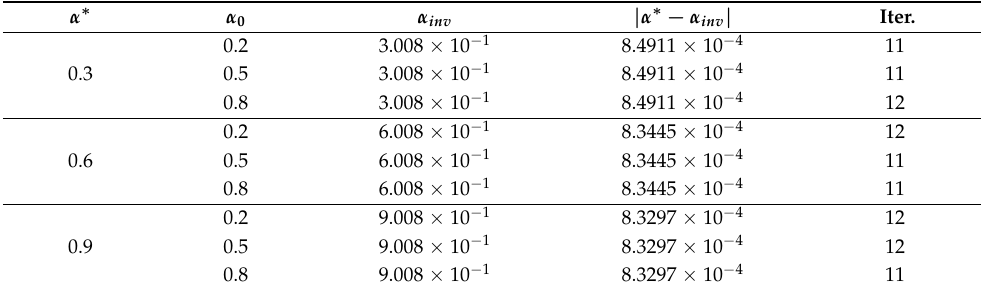
Table 5. Numerical results of different α ∗ = 0.3,0.6,0.9 with different initial guesses α 0 = 0.2,0.5,0.8 in Test 3.